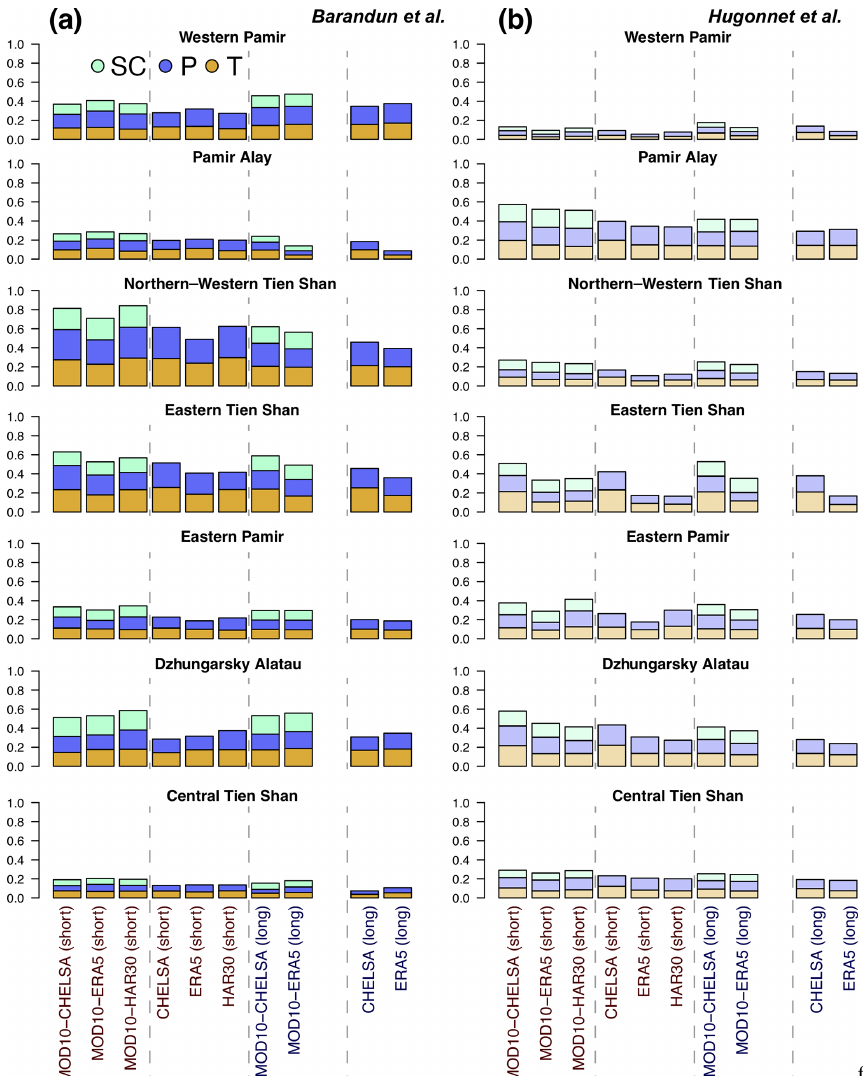
Figure A3. Coefficient of determination ( R 2 ) for variables in the spatial analysis. The shown R 2 is the average for all variable combinations in which the displayed meteorological variable (SC, P , T ) is contained. Mass balance estimates of (a) Barandun et al. (2021a) and (b) Hugonnet et al.